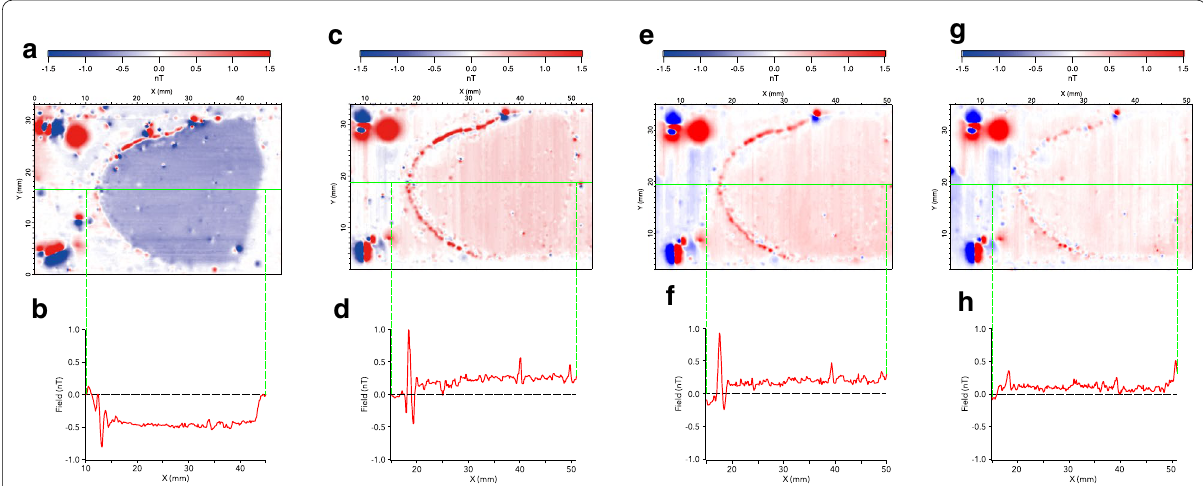
Fig. 3 a , c , e , and g Magnetic images of NRM and after demagnetization at 5 mT, 10 mT, and 30 mT, respectively; and b , d , f , and h Line profiles along a horizontal line in the figures